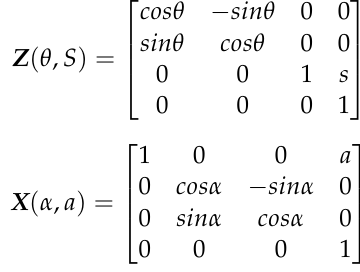
Figure 12. Tripod joint with curve–curve contact.